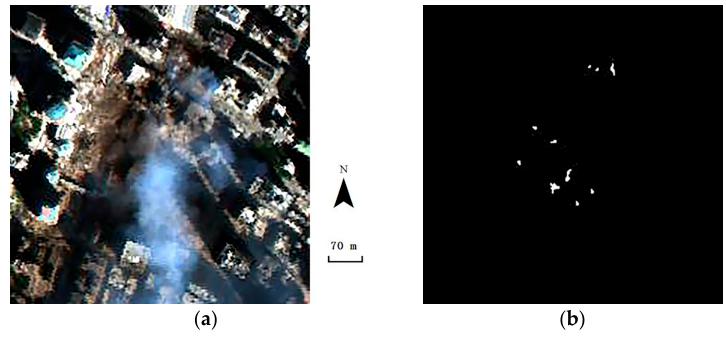
Figure 1. ( a ) AVIRIS image covering the World Trade Center (WTC) in New York City; ( b ) ground-truth map indicating spatial locations of hot spot fires, available from the United States Geological Survey.